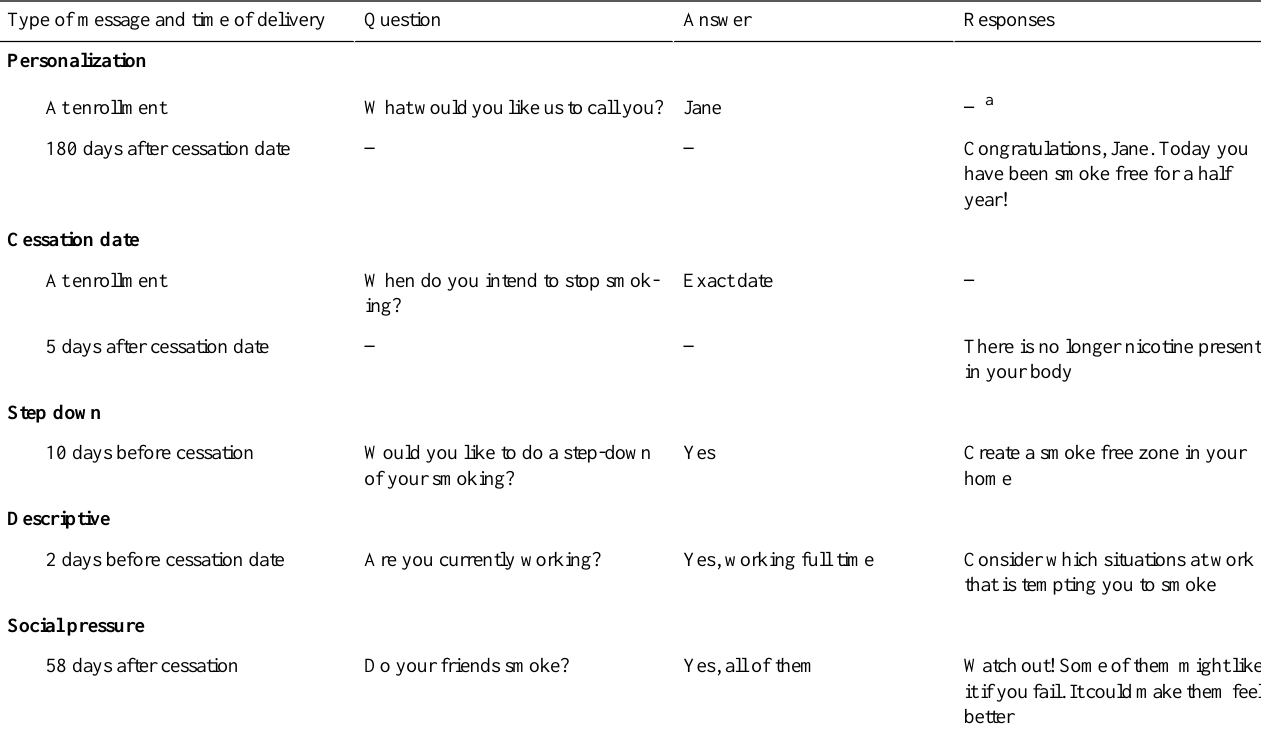
Table 1. Examples from the intervention. ResponsesAnswerQuestionType of message and time of